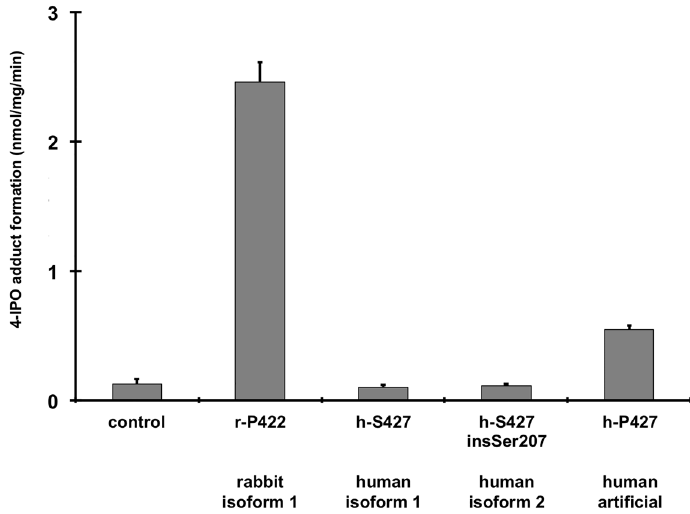
Fig 4. Bioactivation of 4-IPO to a stable NAC/NAL adduct. The NADPH-dependent formation of NAC/NAL adducts by membranes isolated from HepG2 cells stably transduced with the different CYP4B1 cDNAs